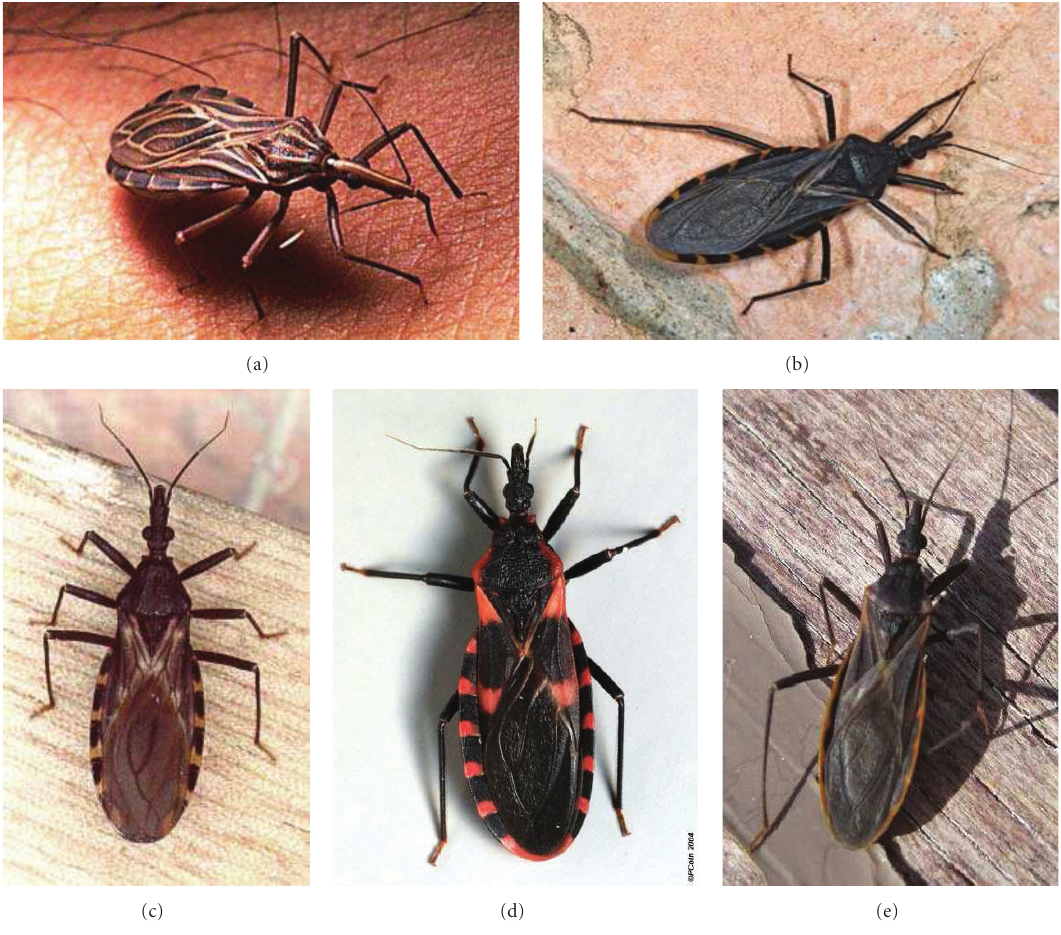
Figure 1: Triatomine bugs. (a) R. prolixus , picture adapted from http://www.jyi.org/articleimages/185/originals/img0.jpg; (b) T. gerstaeckeri, picture adapted from http://theearlybirder.com/insects/hemiptera/reduviidae/index.htm; (c) T. infestans , picture adapted from http://www. k-state.edu/parasitology/546tutorials/ARTHFIG01.JPG; (d) T. sanguisuga, picture adapted from http://bugguide.net/node/view/5164; (e) T. rubida, picture adapted from